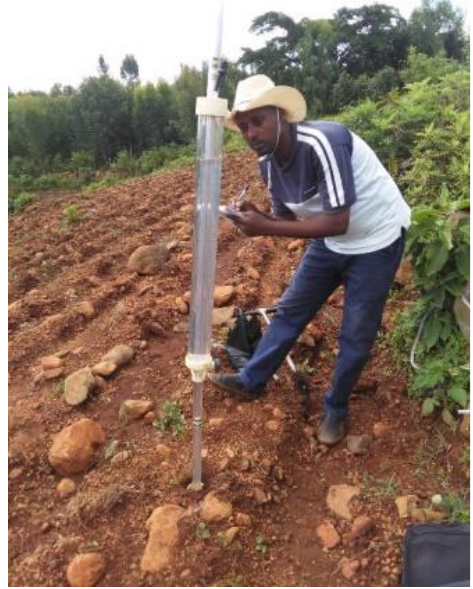
Figure 3. Field measurements of infiltration rate using a Guelph permeameter.